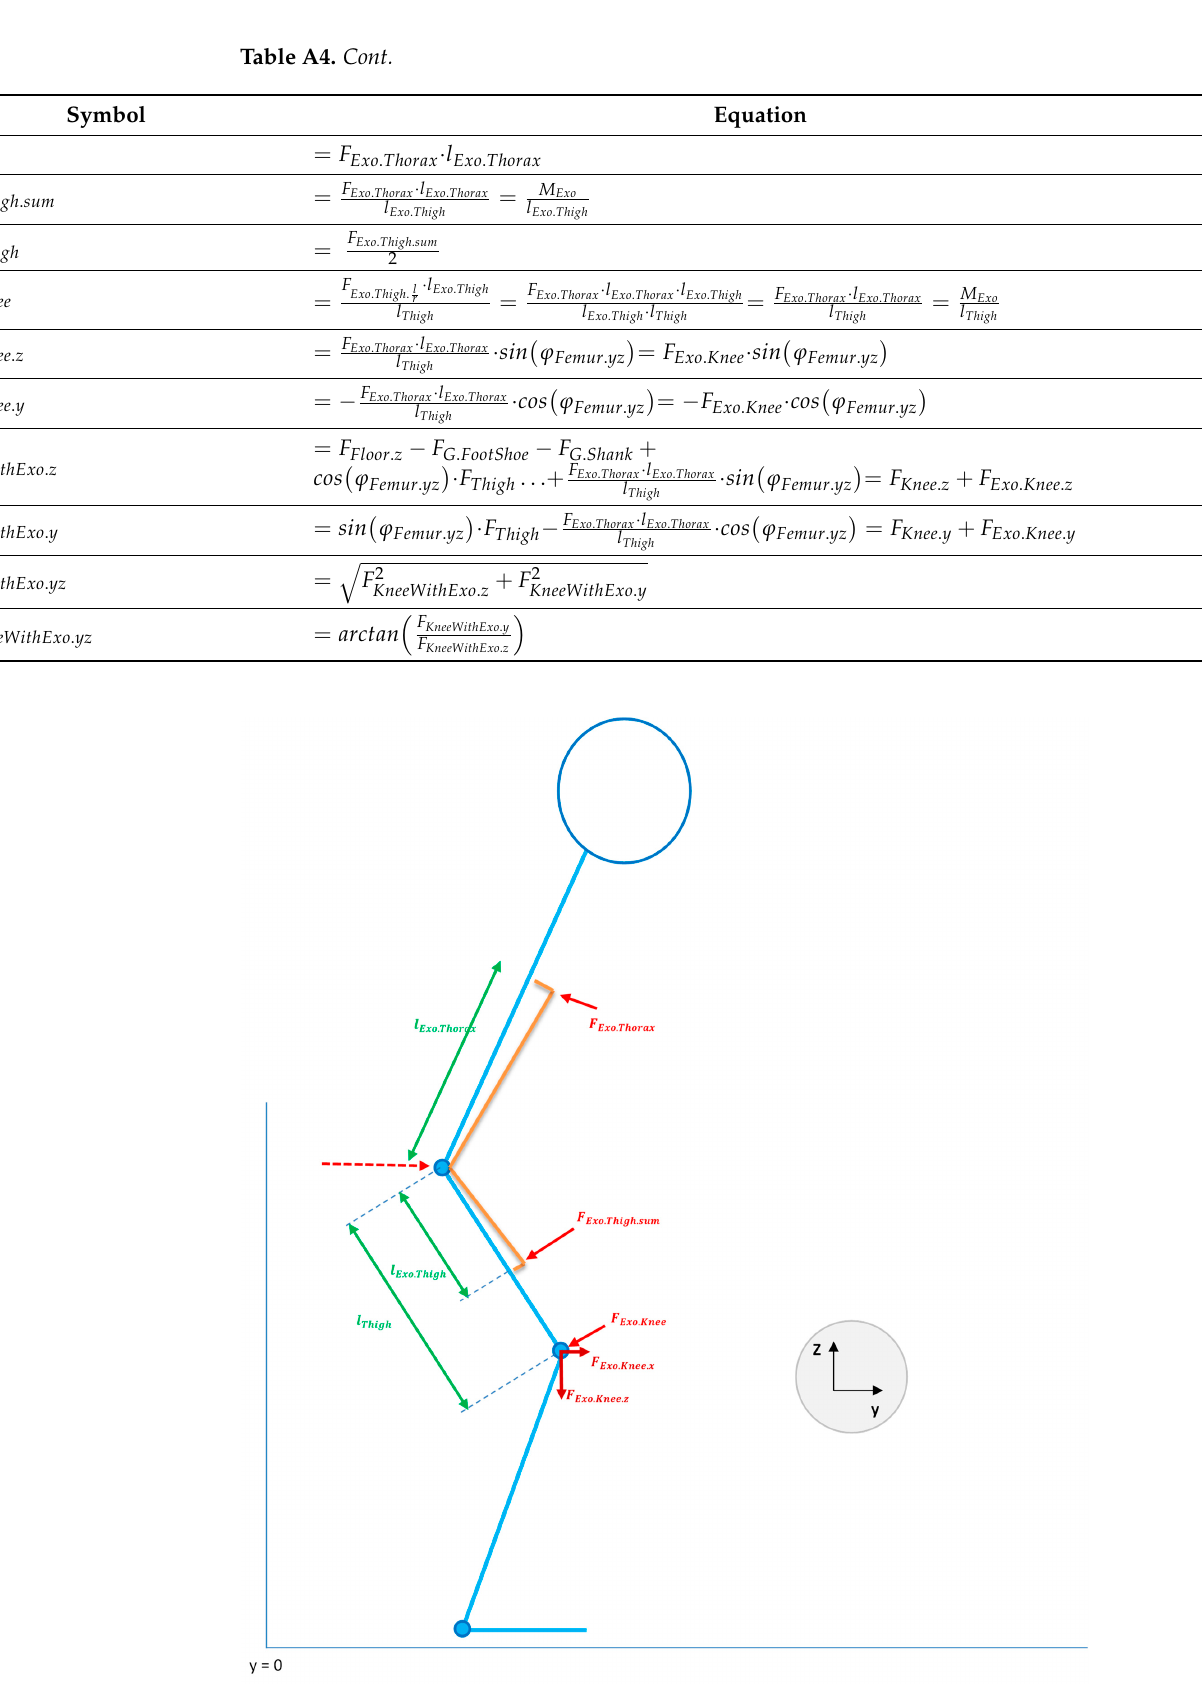
Figure A3. Calculations of knee joint forces including the contribution of the